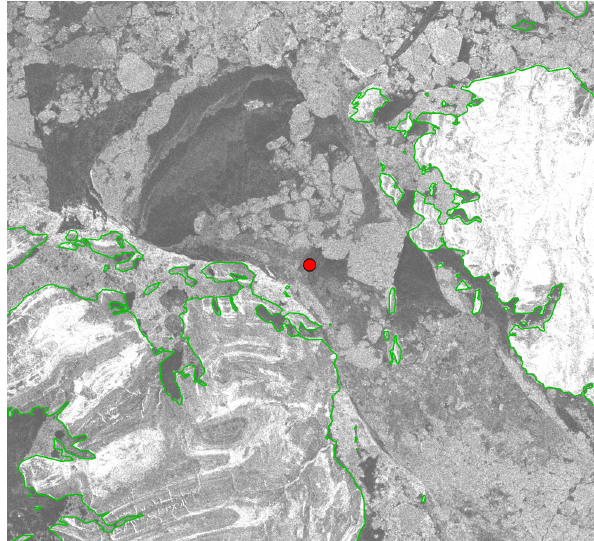
Figure 5. Fast ice in the Penny Strait on 15 January 2010. First- year ice appears dark. A red dot marks the sonar’s location. (RADARSAT Data and Products © MacDonald, Dettwiler and As- sociates Ltd. (2010) – all rights reserved. RADARSAT is an official mark of the Canadian Space